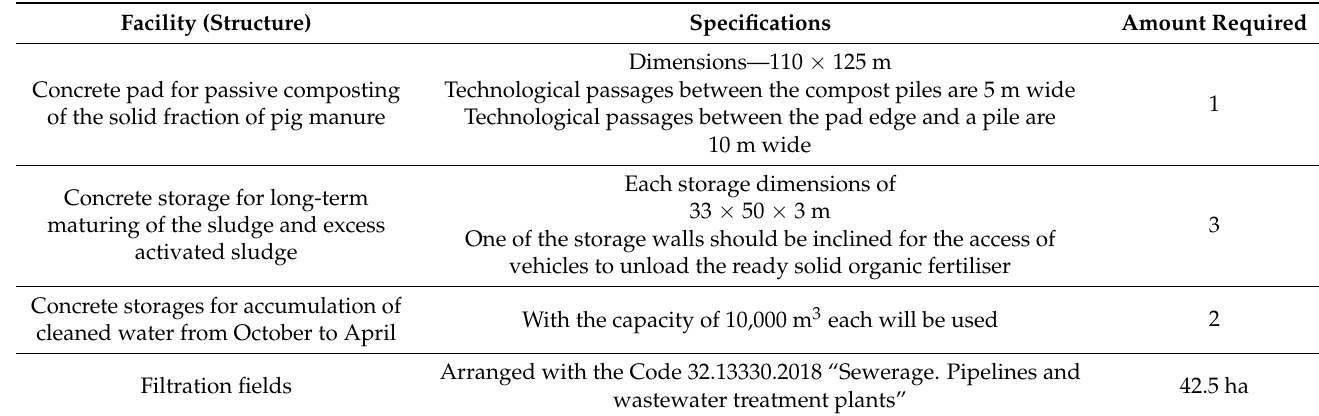
Table 4. Required facilities (structures) for the selected